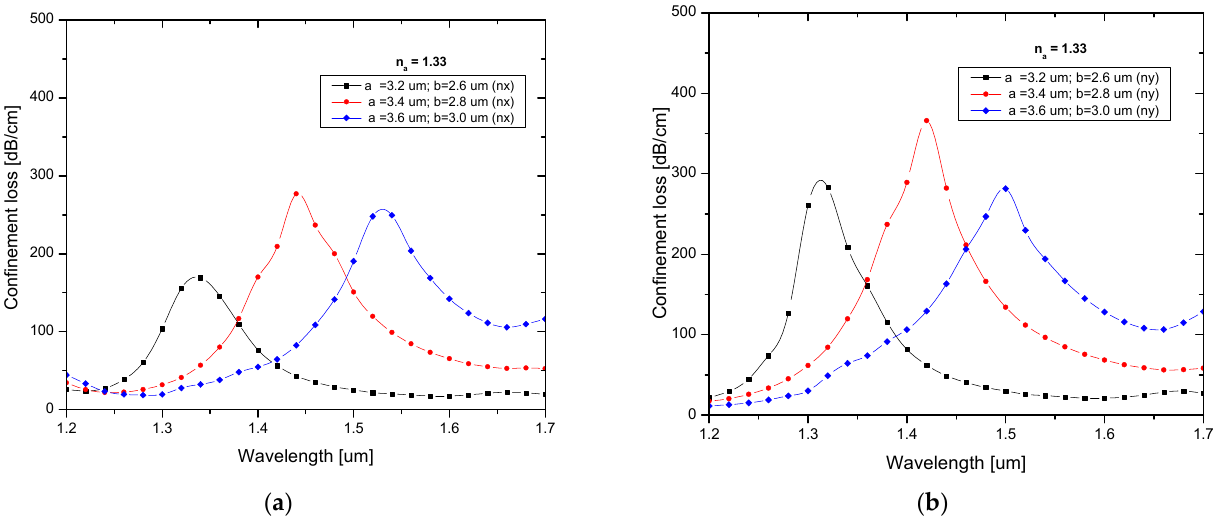
Figure 4. Confinement loss characteristics of different major and minor axes for ( a ) X-polarization and ( b ) Y-polarization.